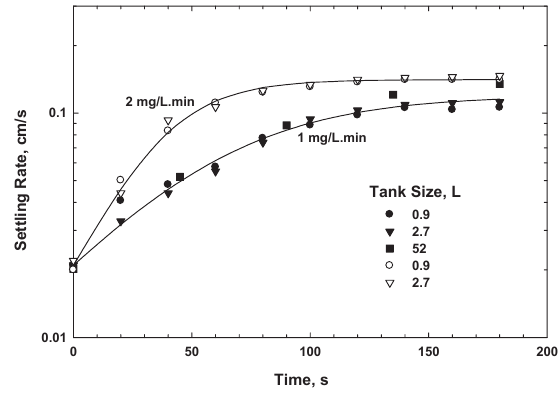
Fig. 8 Scale-up conditions for initial floc growth rate. Effect of tank size and agitation rate on settling rate for the flocculation of kaolin. Data of Maf- fei 34) .